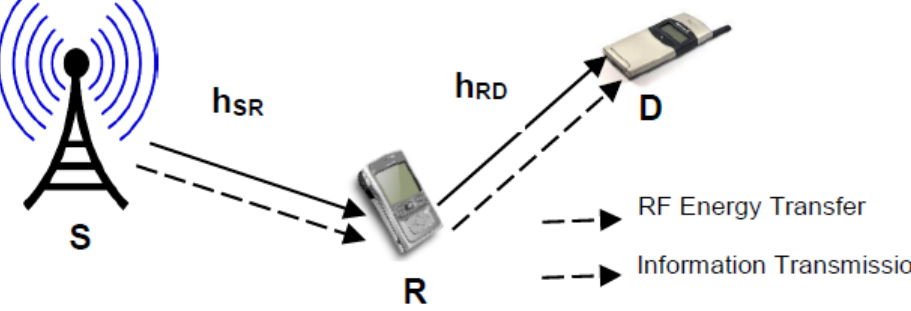
Figure 1. System model for a SWIPT for cooperative communication